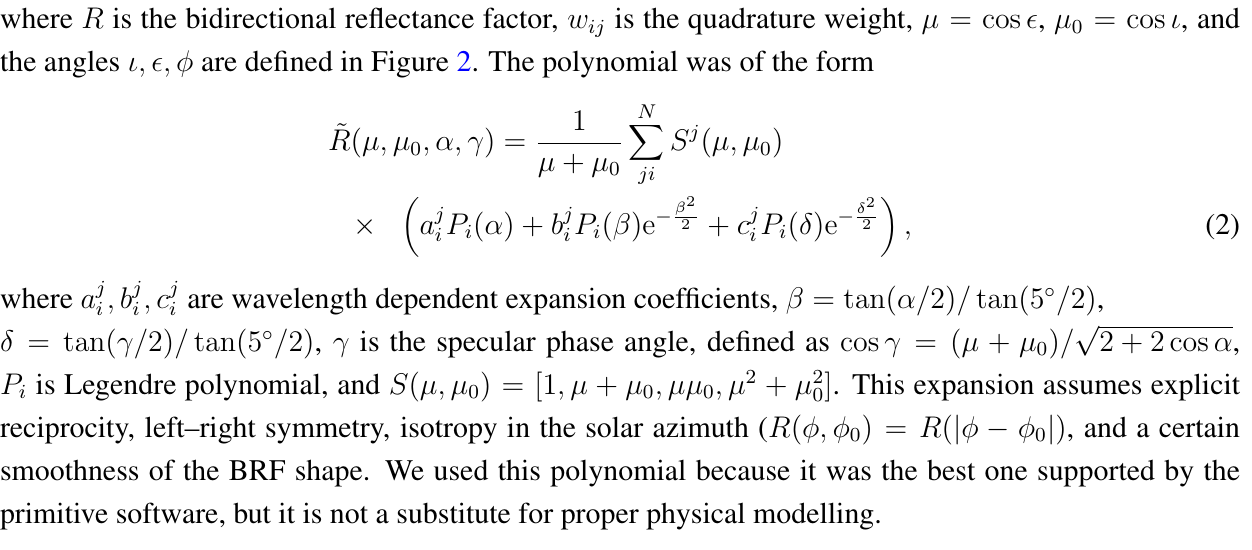
Figure 3. The illumination spectra used for various broadband-albedo computations. The solid line is the incident sunlight to the surface that is used for surface broadband albedo. We measured it on 18 May 2009 in Sjökulla in clear sky conditions with a solar zenith angle of about 60 ◦ . We used the dashed line to compute the PAR (photosynthetically active radiation) albedo. The dotted line represents the solar radiation above the atmosphere, and was used for the top of atmosphere (TOA) albedo (with two technical modifications to the atmospheric water vapour absorption bands around 1,400 nm and 1,800 nm to deal with instrument noise in the sunlight measurements). All spectra are normalised to the same